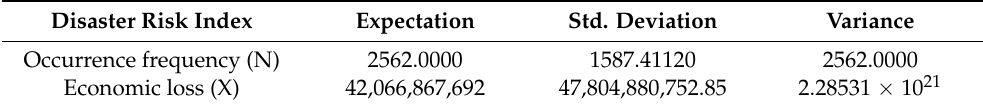
Table 2. Descriptive statistics disaster risk